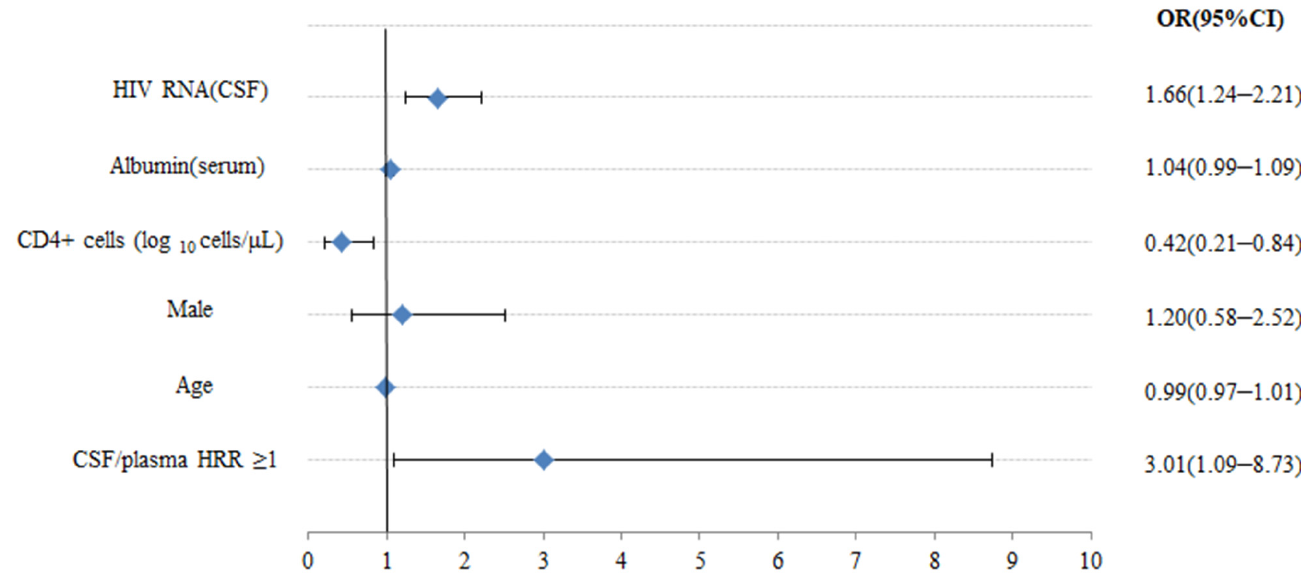
Figure 2. Multivariate logistic regression analysis between clinical features and CNS co-infection. OR—odds ratio; CI—confidence level.